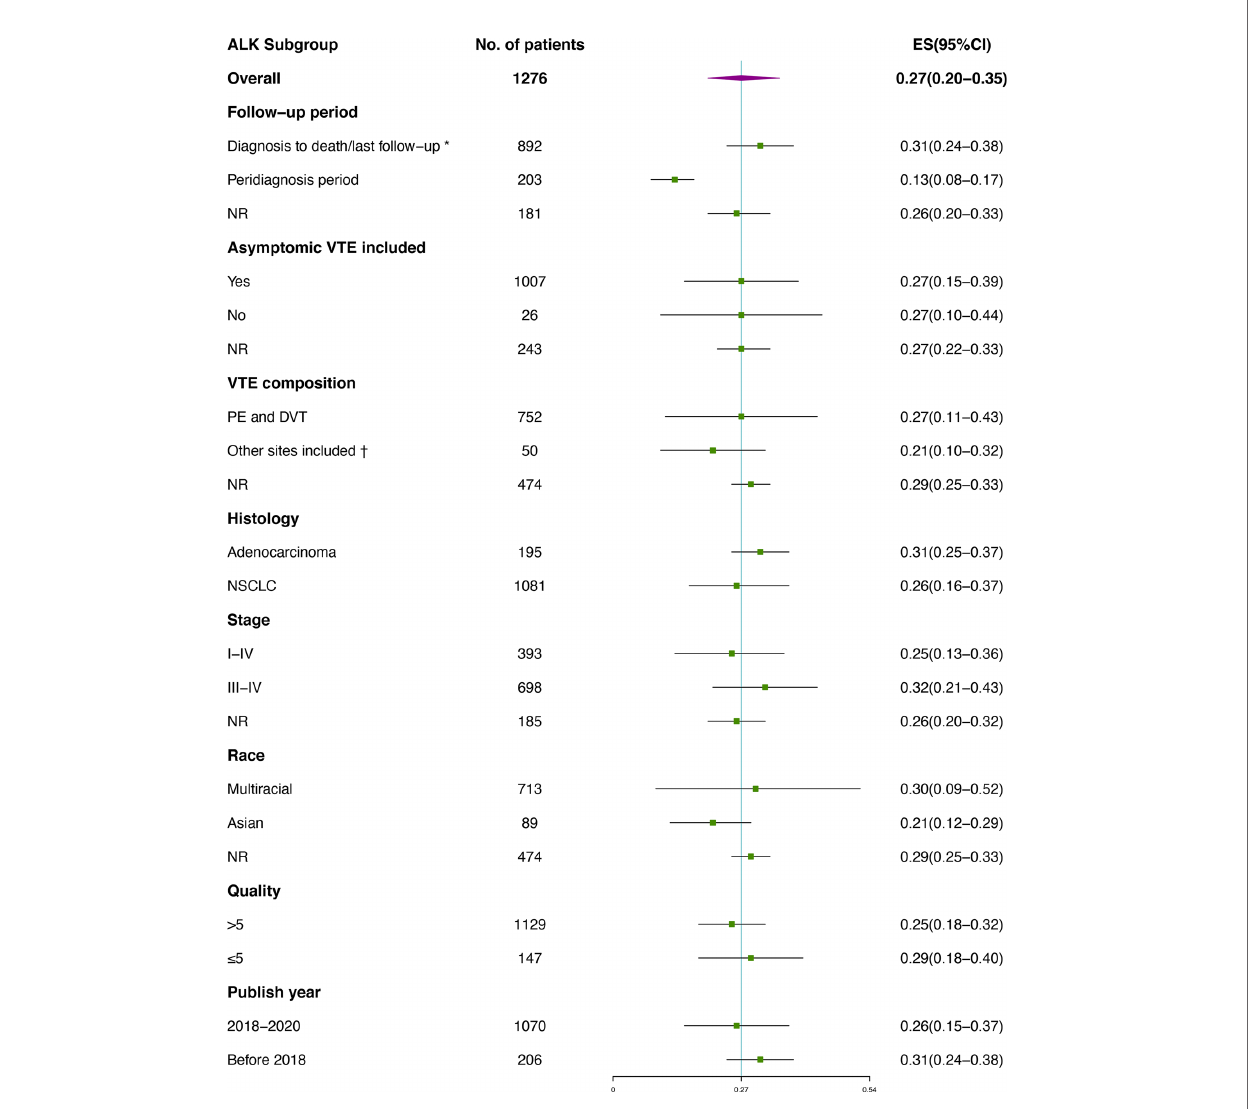
FIGURE 4 | Subgroup analysis of VTE incidence in ALK rearranged patients. *Studies containing VTEs that occurred prior to diagnosis were also included; † Besides PE and DVT, venous thrombosis occurred at other sites were also included, including vena cava, neck vein, portal vein and other sites. No catheter-related events was